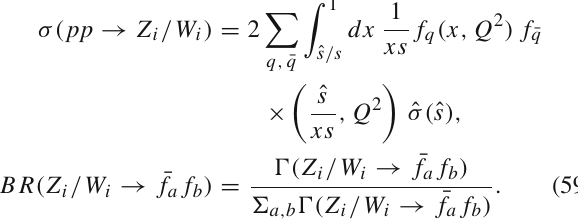
Fig. 1 Ratio of gauge boson masses, m i / m W for a benchmark value V 2 / V = 10 − 3 , V = 10 TeV, g L = 0 . 63, and g R = 0 . 71 g L . The horizontal dotted black line corresponds to m i = m W